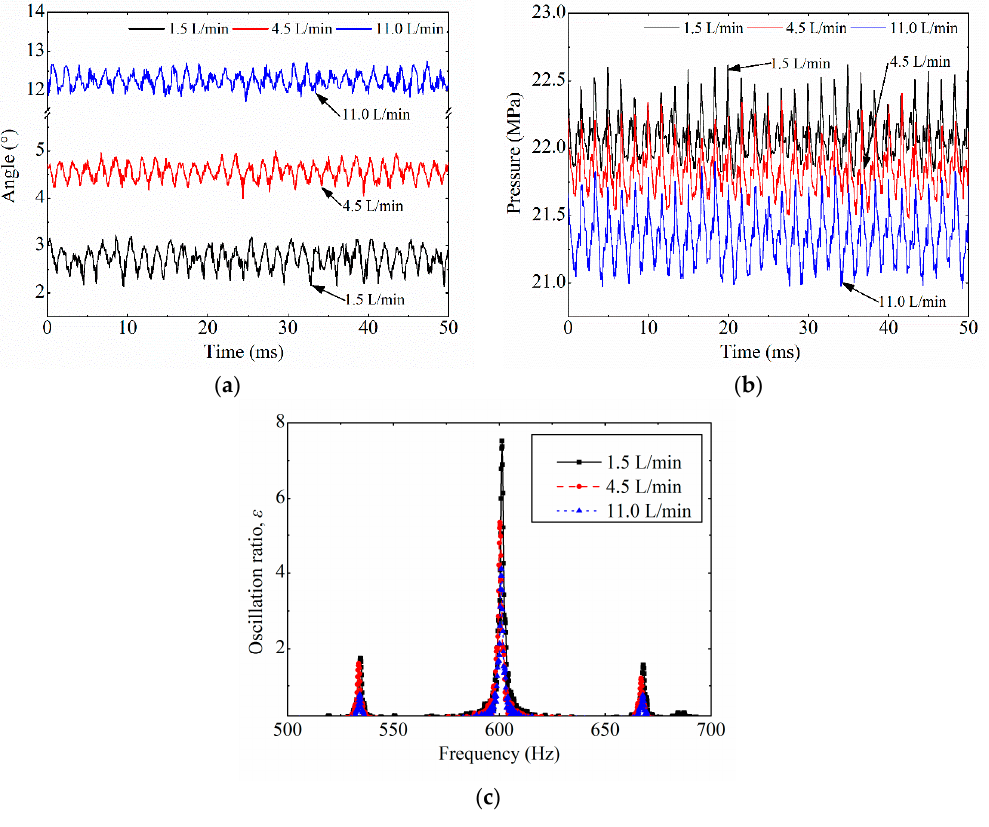
Figure 5. Experimental results. ( a ) Swash plate angle; ( b ) outlet discharge pressure; and ( c ) fast Fourier transform (FFT) results of the ratio of angle oscillation to pressure pulsation.